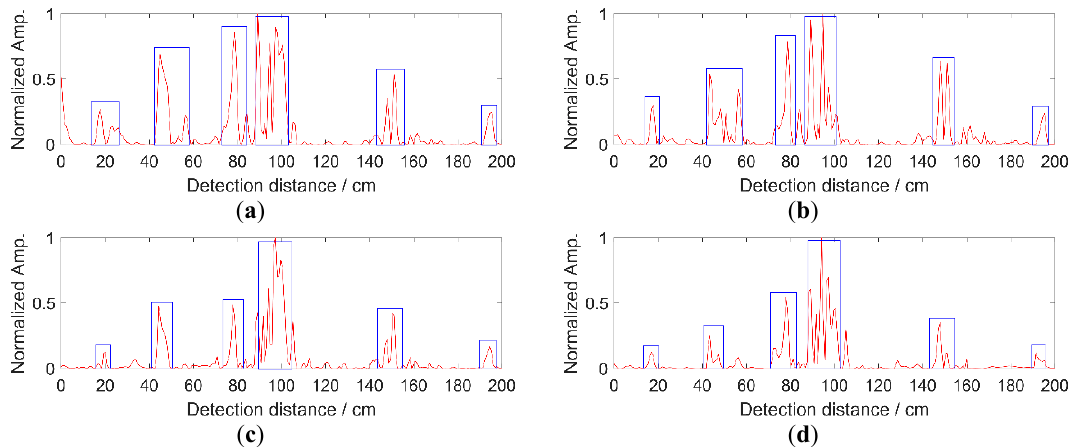
Figure 12. Defect detection results of pipeline at different lift-off distances in laboratory. ( a ) Lift-off distance is 0.5 m; ( b ) Lift-off distance is 1.0 m; ( c ) Lift-off distance is 1.5 m; ( d ) Lift-off distance is 2.0 m. Six blue boxes from left to right are the defect locations on pipeline, which are axial crack, transverse crack, square groove, through hole, blind hole, and 45-degree crack in turn.